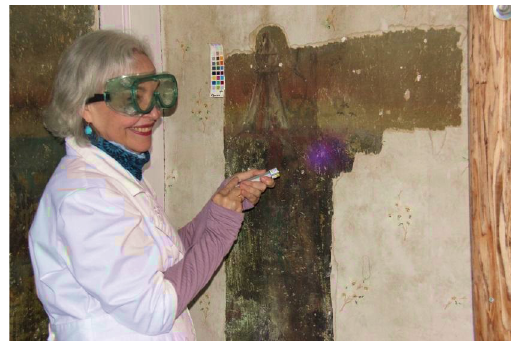
Fig 10: A dedicated UV light source was also utilized (with use of protective eye goggles).